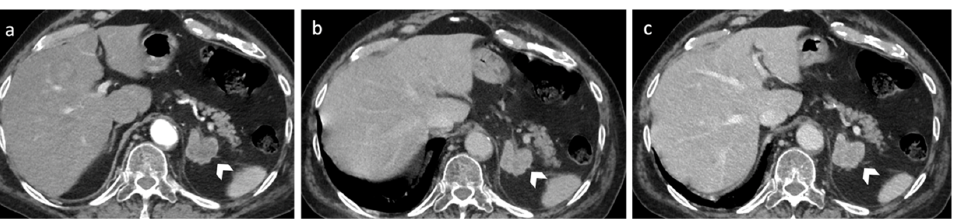
Figure 7. A 67-year-old female with metastatic lung cancer. Axial arterial ( a ), portal ( b ), and delayed phase ( c ) showing large, inhomogeneous, left solid 4 cm adrenal lesion with irregular margins and foci of low attenuation, in keeping with partial necrotic phenomena. No infiltration of surrounding structure is seen. The lesion was referred to as adrenal metastasis. On MRI, adrenal metastases usually appear hypointense on T1-weighed imaging and hyperintense on T2-weighed imaging, with cystic change and necrosis; they may show ring or uneven enhancement after contrast administration (Figure 8) [37].